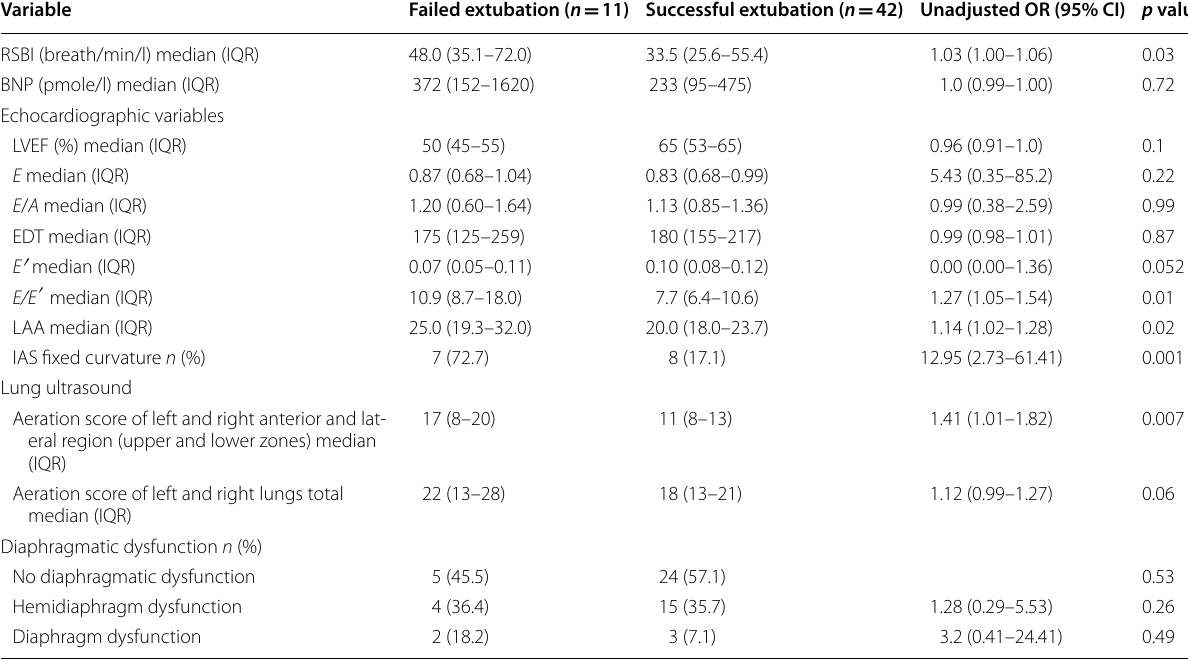
Normal values of the parameters listed in the table are as follows: RSBI: < 105, BNP < 29 pmol/l, LVEF < 50%, E 73 192 40 ms, E ′ 12 4 cm/s, E / E ′ 10 ± ±